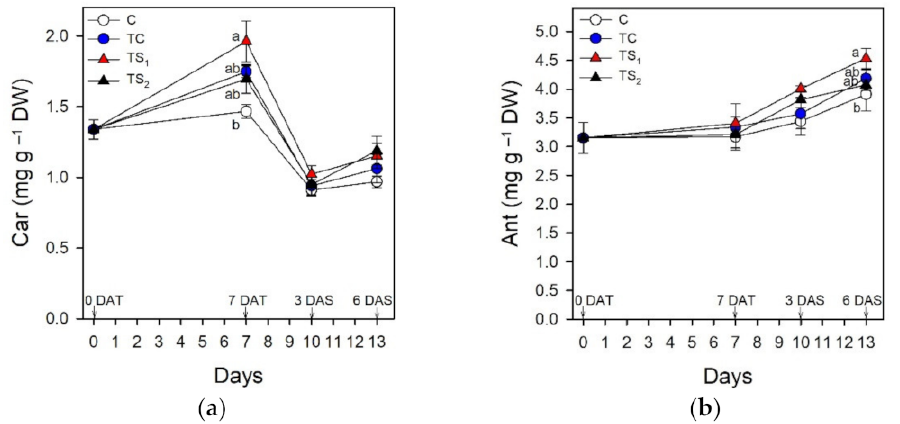
Figure 4. Leaf contents of total carotenoids and anthocyanins in purple basil cv. Red Rubin at 0 and 7 days after bacterial treatment (0 DAT and 7 DAT, respectively) and at 3 and 6 days after water stress (3 DAS and 6 DAS, respectively): ( a ) total carotenoids (Car); ( b ) total anthocyanins (Ant). Values are means ± SE ( n = 3). Different letters indicate significant differences among bacterial treatments and control (one-way ANOVA with Fisher’s LSD test, p ≤ 0.05).